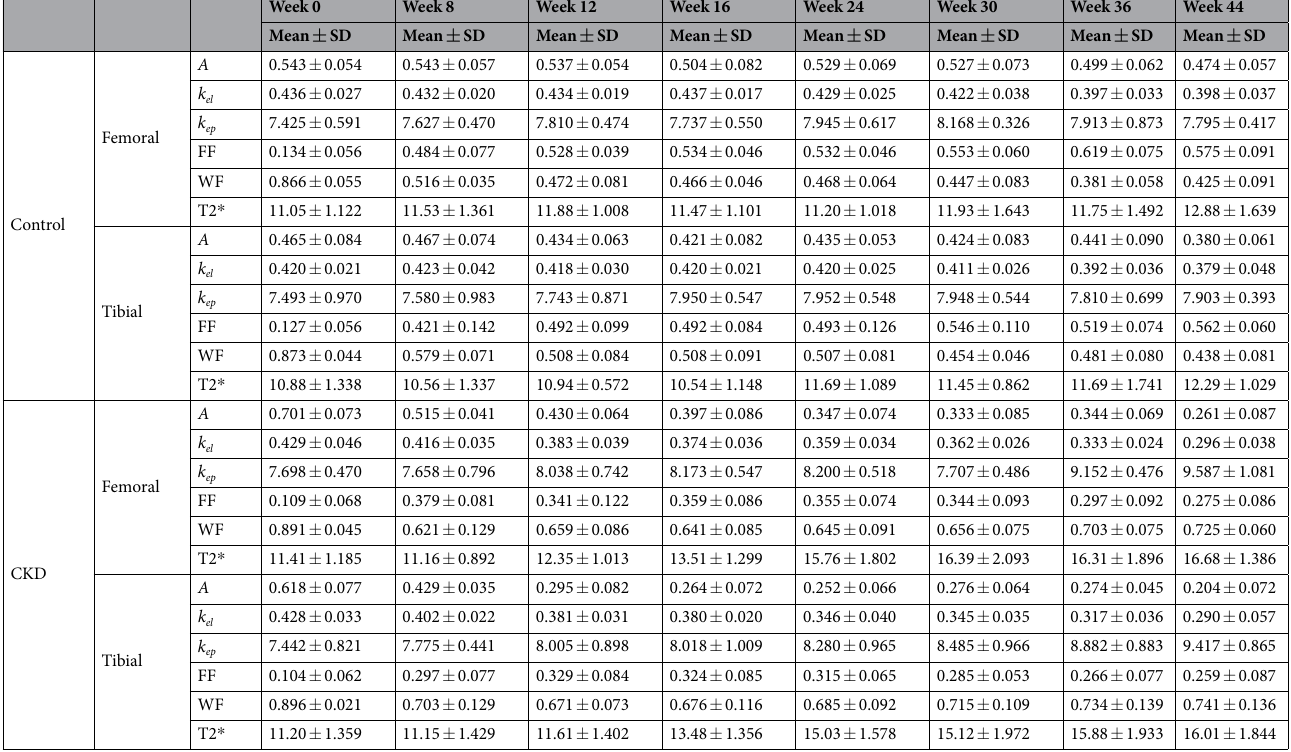
Table 1. The mean and SD of multi-parametric MRI parameters for the femoral and tibial subchondral bone marrow. Abbreviations: A : amplitude; k el : elimination constant; k ep : permeability rate constant; FF: fat fraction;